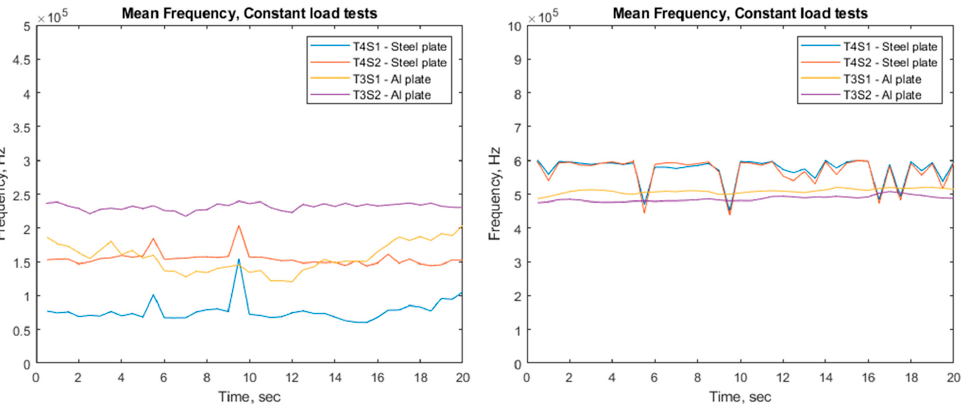
Figure 16. ( Left ) Mean frequency of tool steel indenter on steel sheet and tool steel on aluminium sheet under constant load including the sub 300 kHz region. ( Right ) Mean frequency of tool steel indenter on tool steel sheet and tool steel on aluminium sheet under constant load with 300 kHz high pass filter. The centroid frequency (Figure 17, top) shows the steel typically has a higher centroid frequency (600 kHz) than the aluminium (500 kHz) throughout the duration of the con- stant load test, and the centroid frequencies for both materials remain almost constant. However, Shannon entropy (Figure 17 bottom) shows an increase with load for the alu- minium sample not seen in the steel sample.